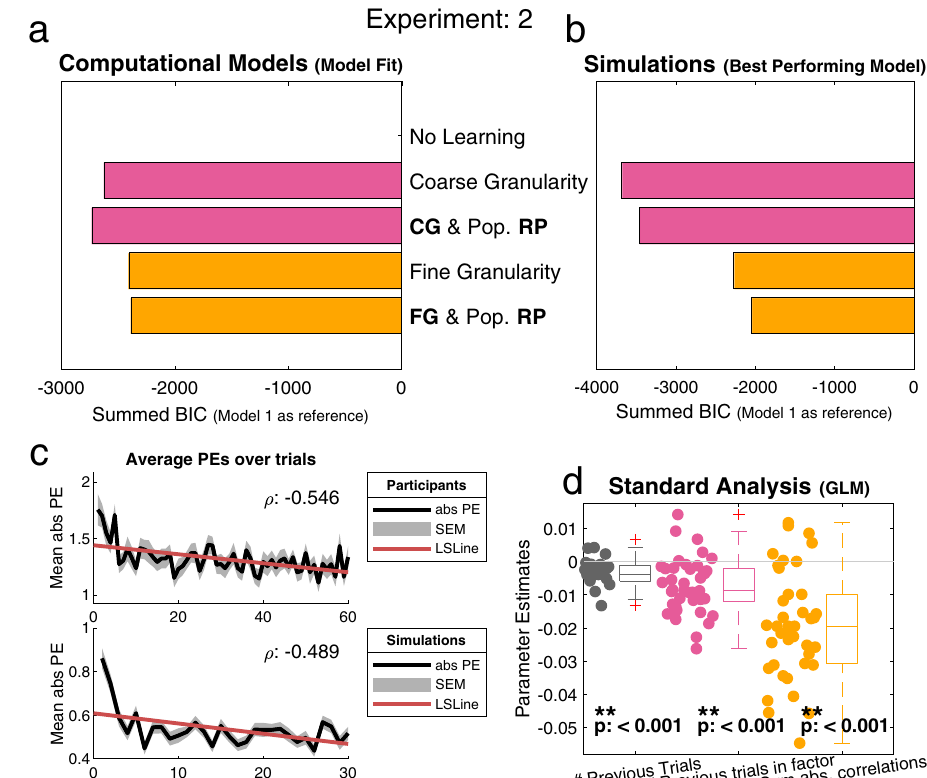
Fig. 4 | Overview of the main analyses for experiment 2. In this experiment participants learned about arti fi cial pro fi les which did not have the trait similarity structures. Results indicate that participants use a coarse granularity structure whenlesssocialinformationispresent. a Model3[CoarseGranularity&Population RP] is the best fi tting model ( n =41). This model uses the average population as a reference point and coarse granularity for generalization. b Simulated data for the best performing model ( n =41). Unlike participants ’ data, Model 2 [Coarse Granu- larity] was the best performing model,demonstrating that participants could have used a more optimal strategy. c Both plots display the average absolute PEs over time±SEM.Top)Participants ’ datashowsadecreaseinthePEsovertime( ρ : − 0.546, leastsquaresline,red),thisindicatesparticipantswerelearningovertime.Bottom) simulateddatafromthebest fi ttingmodel(Model3)showsasimilardecreaseinPEs over time, indicating that the models learned in a similar way to participants. d All three regressors (representing: 1 RW learning, 2 Coarse granularity, 3 Fine